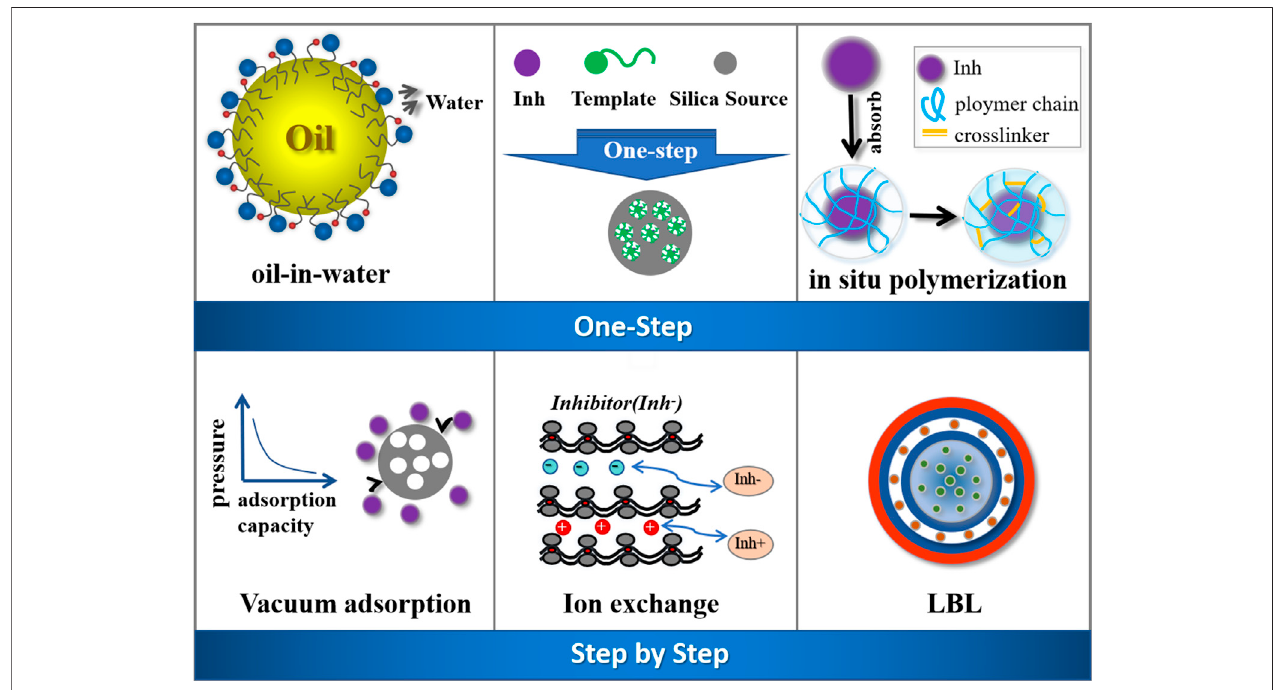
FIGURE 3 | Schematic illustration of common loading methods of corrosion